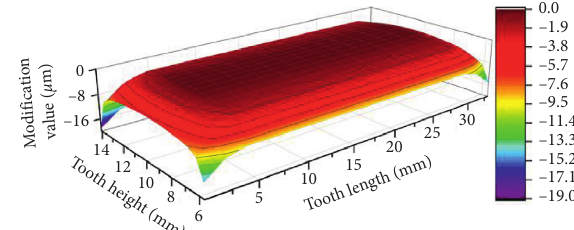
Figure 24: Modification of the input-stage pinion.